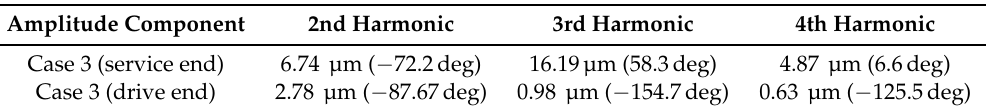
Table 4. Average amplitudes and phases of the two roller element paths (see Figure 5) used in Case 3 for the service end and the drive end. For the phase, the circular average was